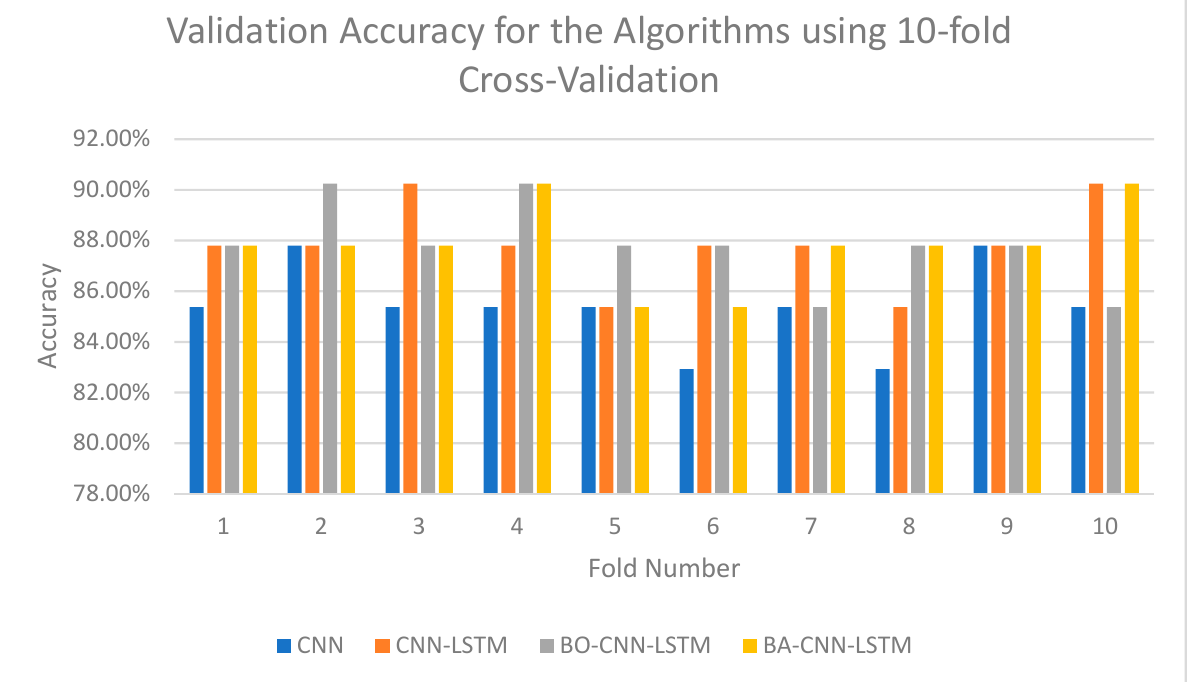
Figure 16. Validation accuracy for the algorithms using 10-fold cross-validation (ECG dataset).